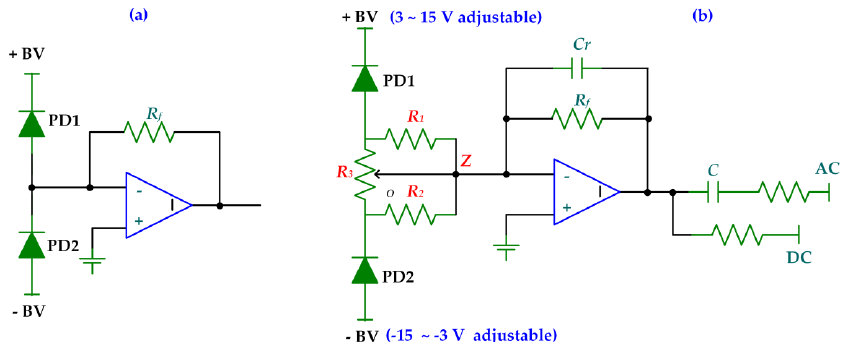
Figure 3. Schematic of the circuit of photodetector: ( a ) the self-subtraction photodetector scheme; and ( b ) the self-subtraction photodetector scheme with the differential fine-tuning circuit and adjustable BV.